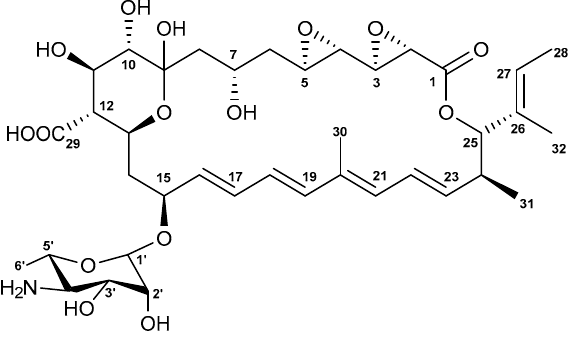
Figure 1. Chemical structure of actinospene ( 1 ).